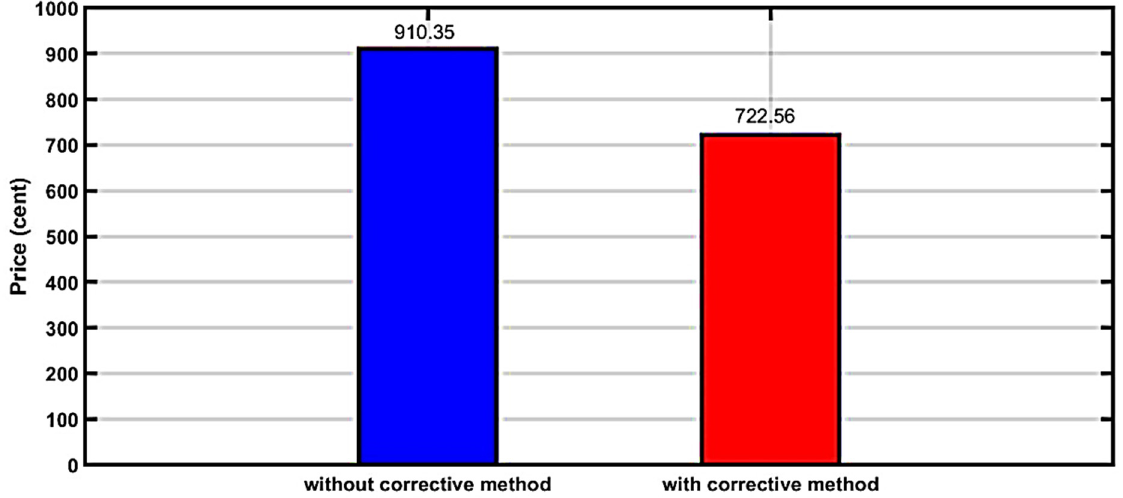
Figure 14. Cost comparison of price without the suggested EMS and with the suggested EMS.